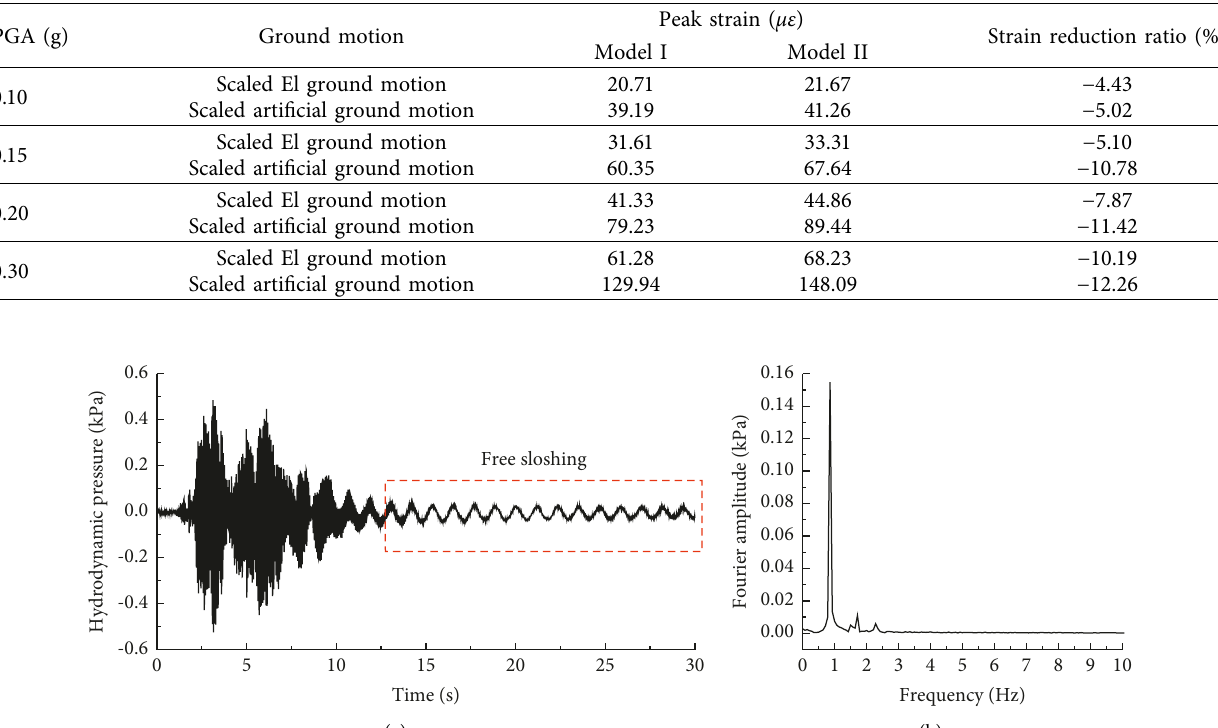
Figure 12: Peak strain curves under different inputs. (a) PGA of 0.10g. (b) PGA of 0.15g. (c) PGA of 0.20g. (d) PGA of 0.30 g. Table 8: Peak strain at the bottom and strain reduction ratio.